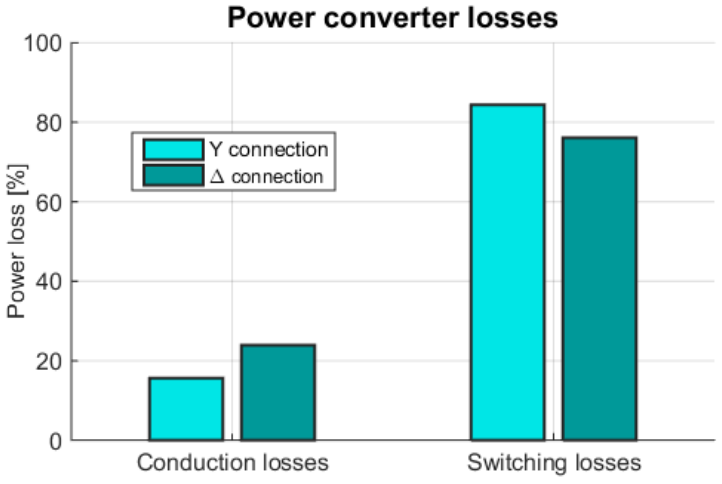
Figure 30. Power converter losses distribution, adapted from